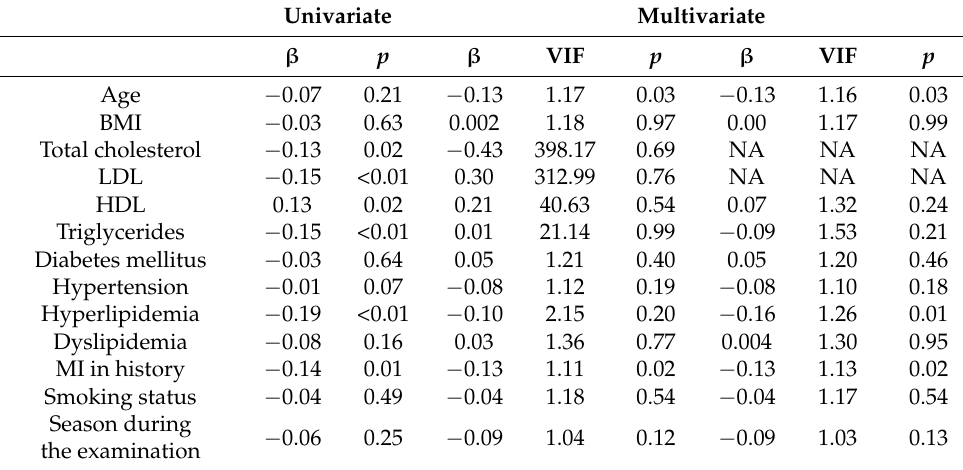
Abbreviations; see Table 2; VIF, Variance inflation factor.